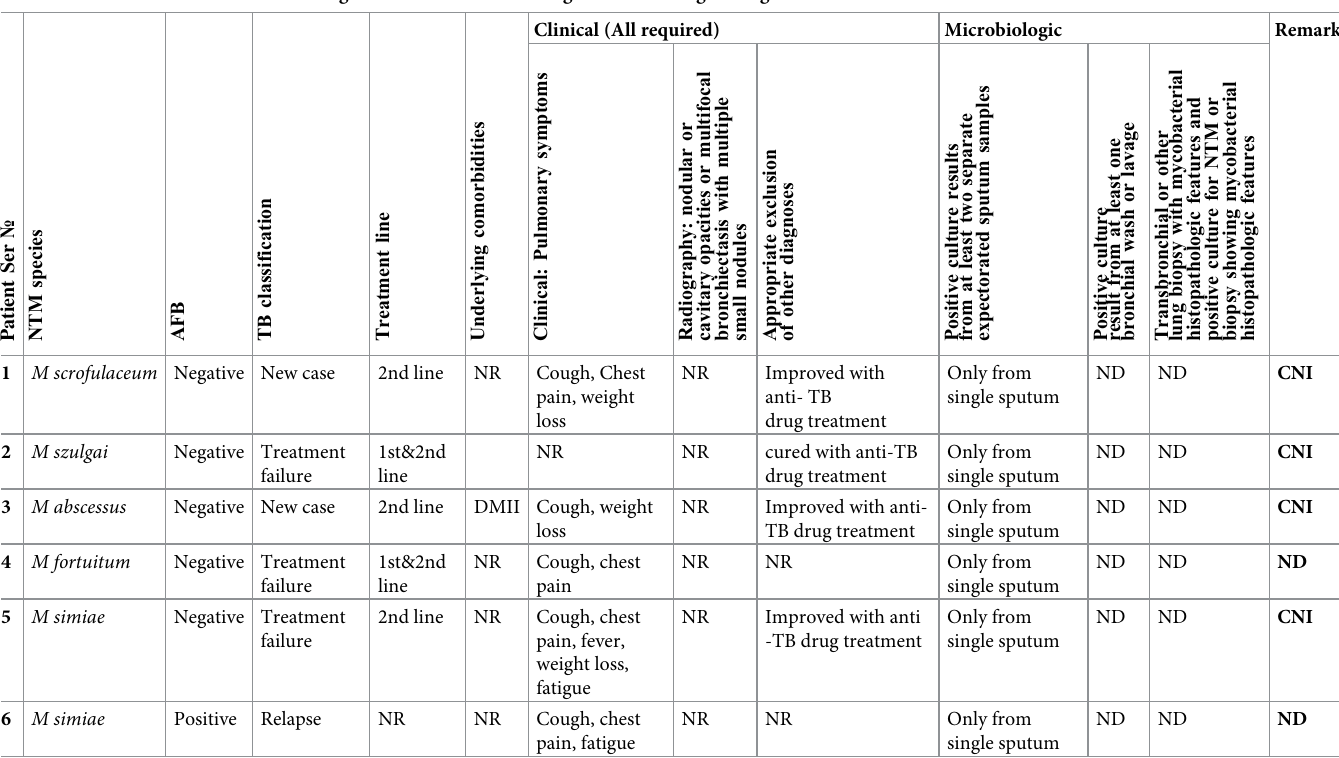
Table 2. Patients clinical and microbiologic characteristics according to the AST diagnostic guide